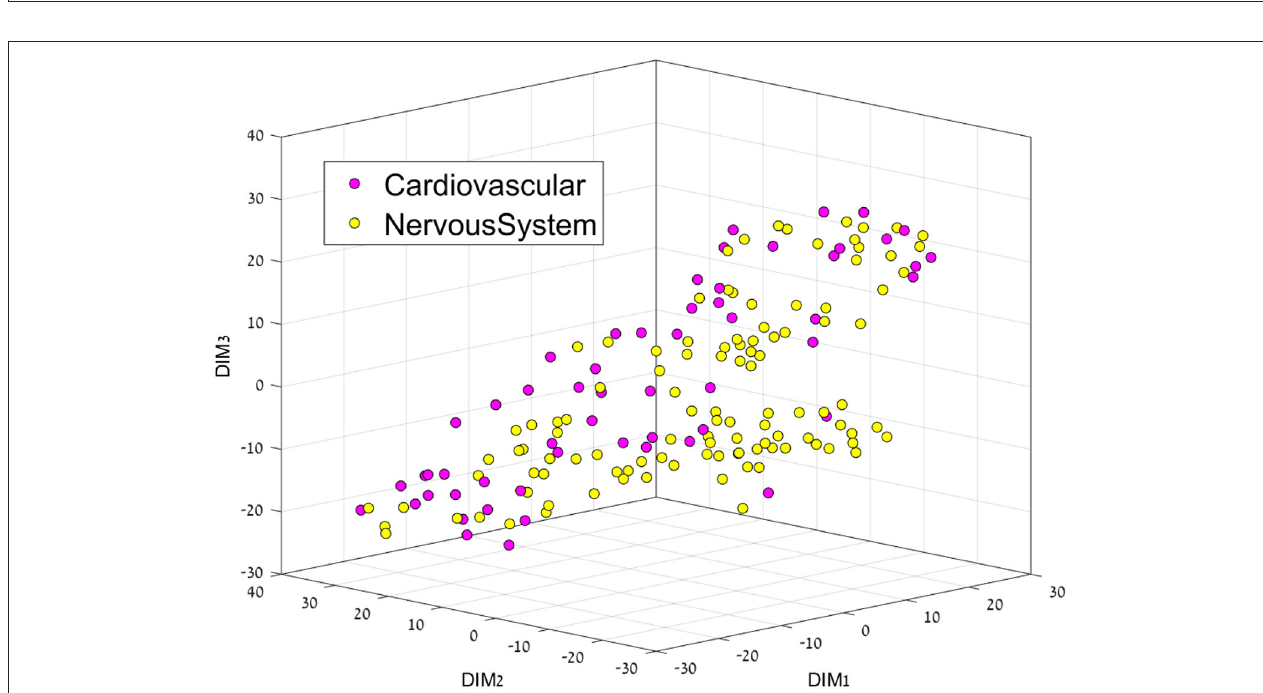
FIGURE 4 | 3D representation of the Cardiovascular-Nervous System feature space using the t-SNE algorithm for dimension reduction.